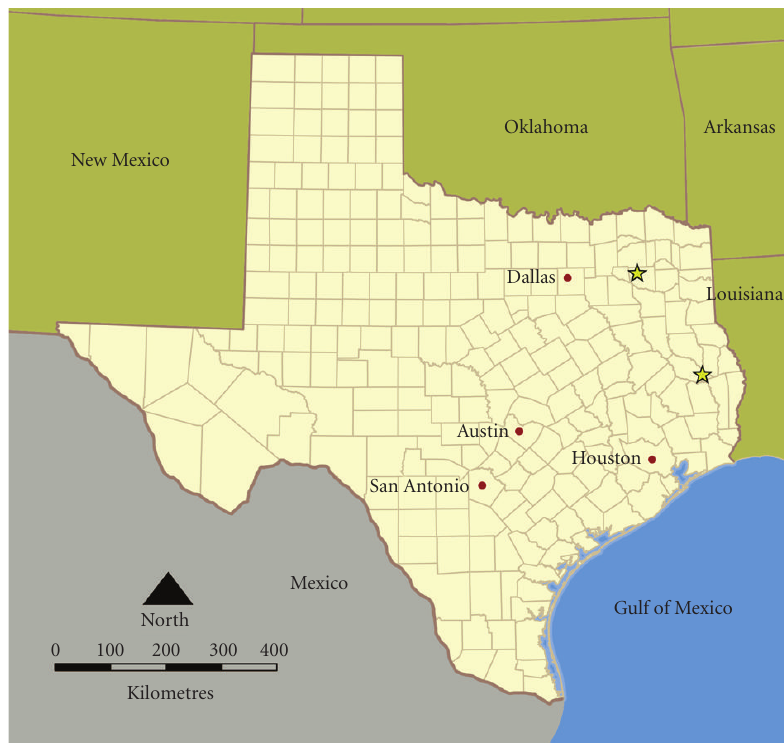
Figure 1: Collection sites in Texas for Panorpa vernalis from material in the Texas A&M Insect Collection. Sites are marked with yellow stars. The upper star corresponds to collection events 1–3 and the lower star to events 4–5 (see the